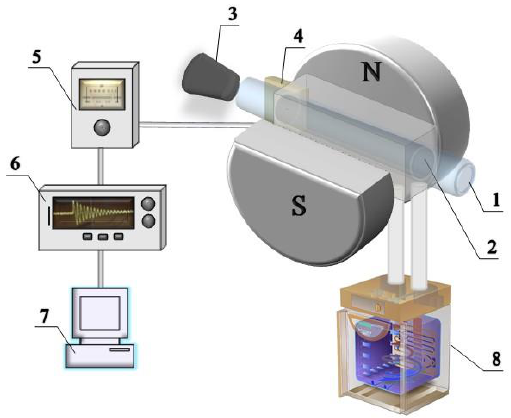
Figure 1. A diagram of the experimental